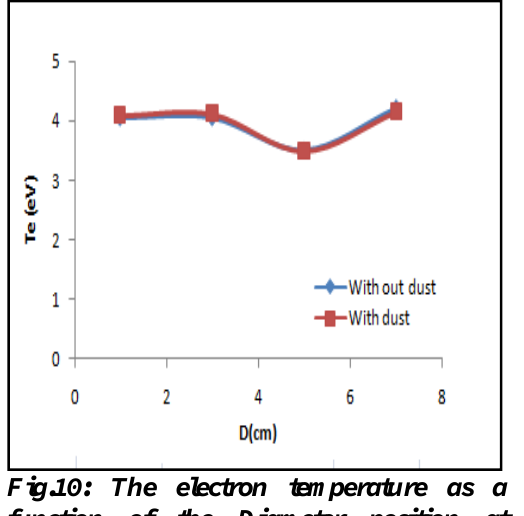
Fig.12: The ion density as a function of the Diameter position at different distances of the probe.